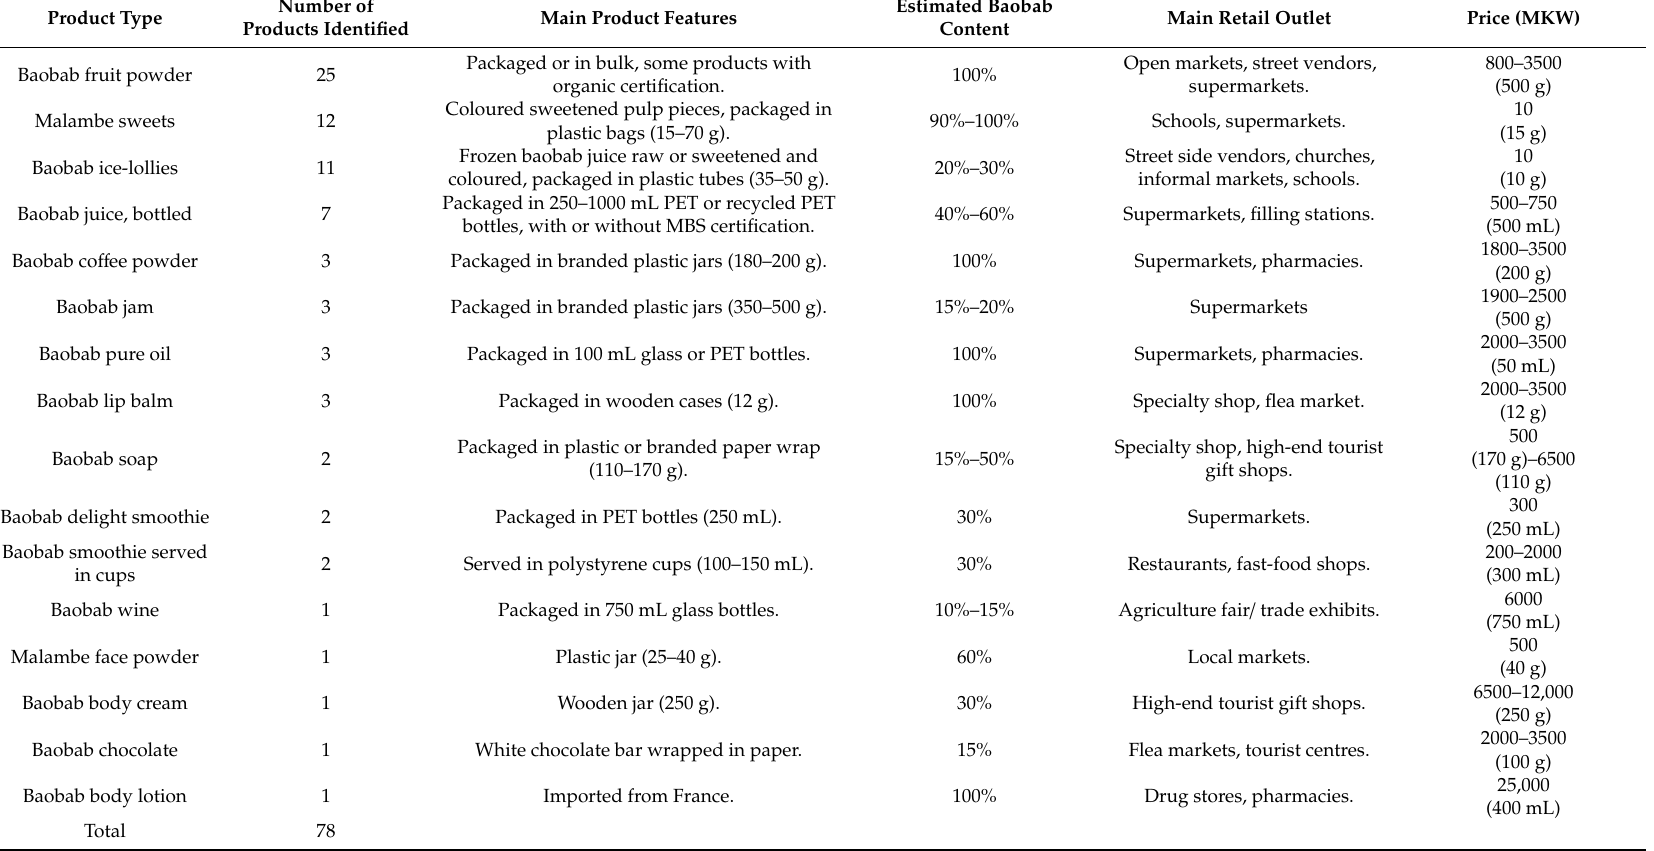
Table 1. Characteristics of processed baobab products in